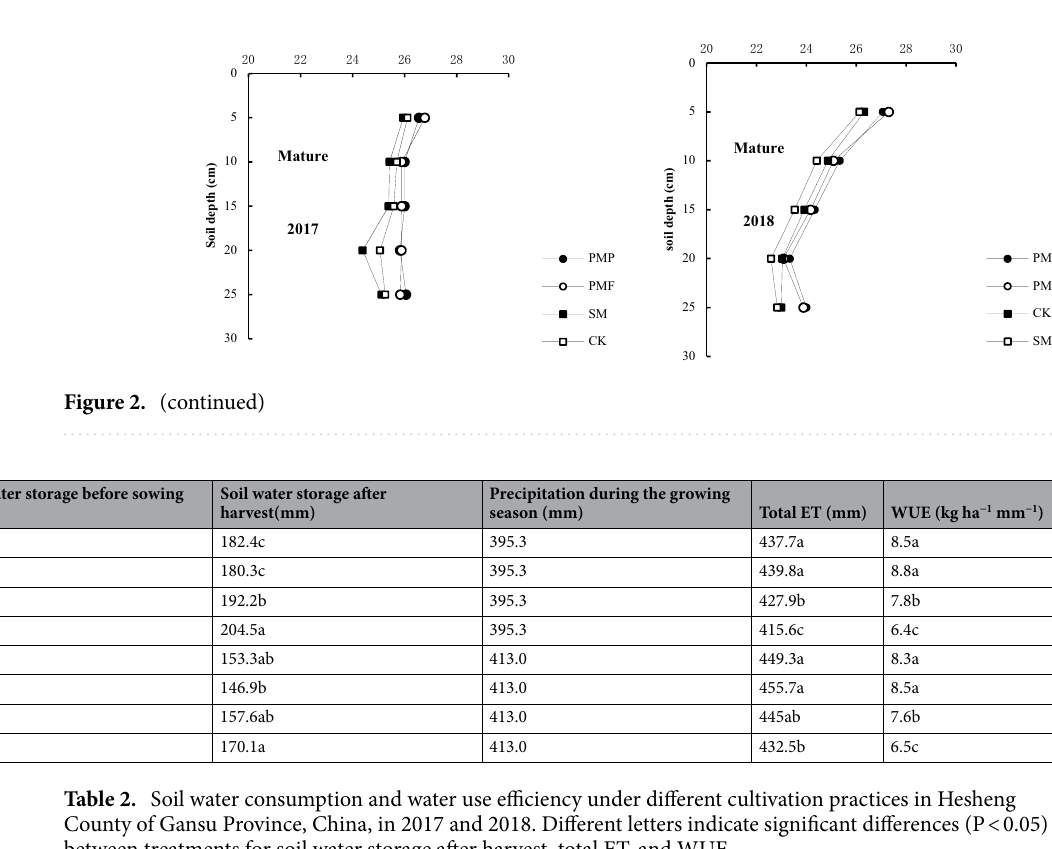
(Table 4). Pod number per plant, 100-seed weight, basic seedlings per hectare, and grain yield varied between the four treatments (Table 4). Across both years, the PMP, PMF, and SM treatments had 35.7, 41.5, and 23.5 % higher average grain yield than CK (P < 0.05), respectively (PMP and PMF treatments did not significantly dif- fer). Pod number per plant increased by 41.3 and 37.1 % in 2017 and 40.1 and 39.4 % in 2018 in the PMP and PMF treatments and 15.0 and 17.8 % in the SM treatment, respectively, compared with CK. The SM and CK treatments had 2.5–3.8 % and 2.5 % more basic seedlings per hectare than the PMP and PMF treatments (PMF